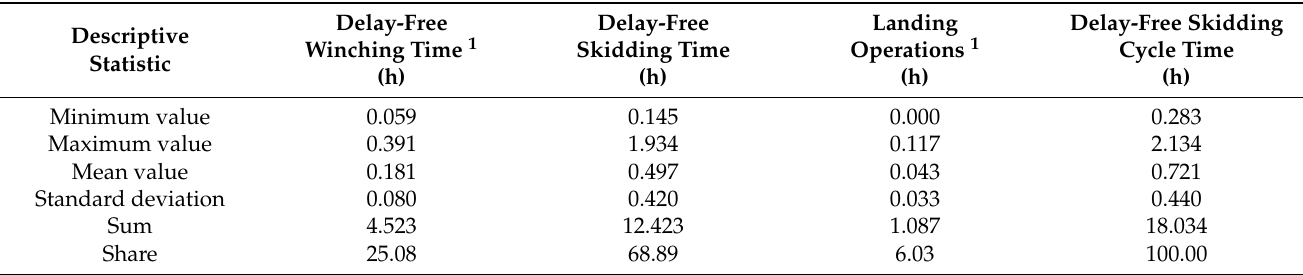
Table 5. Summary statistics of the main operational